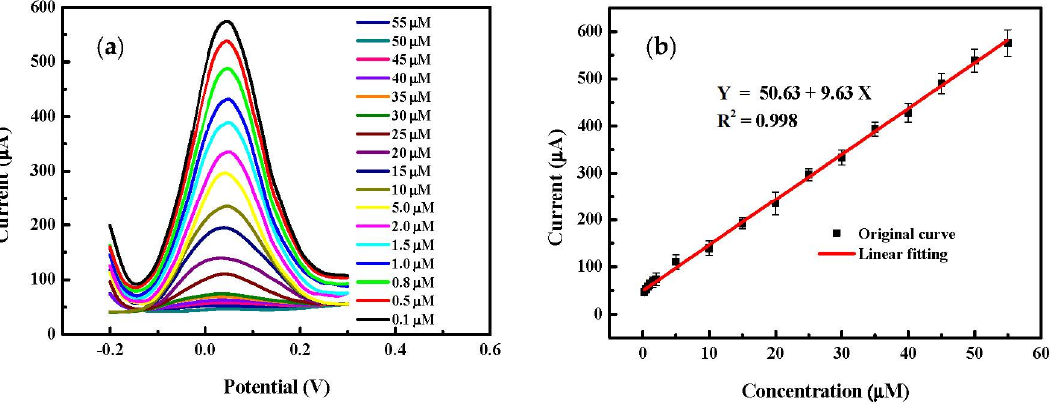
Figure 8. ( a ) SWV of LIC/MWCNT-PANI electrode with variation of the concentration from 0.1 μ M to 55 μ M and ( b ) Calibration curve: Linear fitting of the peak current with the 4-AP concentration. Table 2. Performance parameters of different electrochemical sensor methods for 4-AP detection.